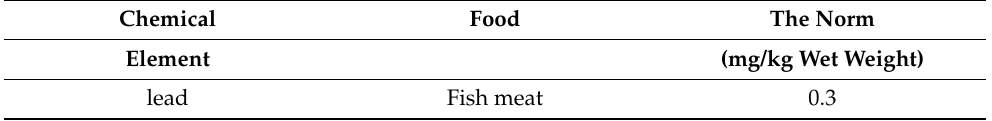
Table 3. Quality standards for Pb in fish meat under EU Regulation № 1881 of 2006, as